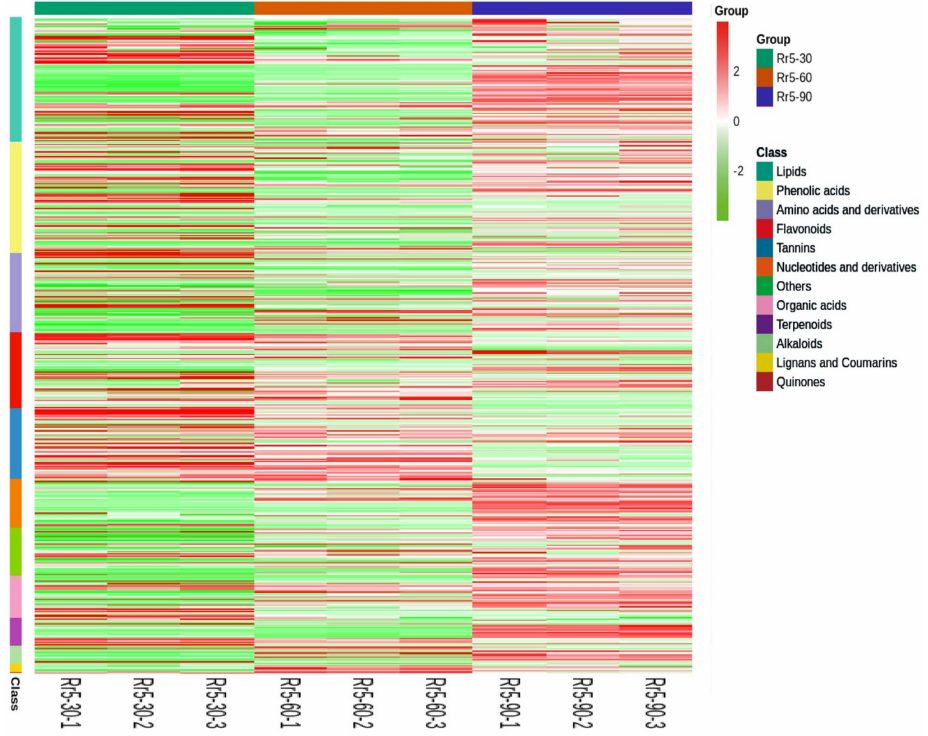
Figure 2. Heatmap of all detected metabolites. Horizontal: sample name, longitudinal: metabolite classification situation. Different colors represent the values for standardized treatments of relative content, ranging from low (green) to high